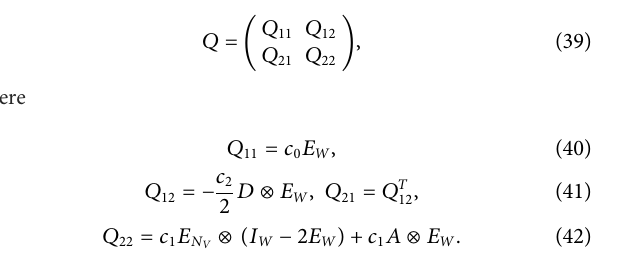
TABLE 3 Characteristics of the graph coloring dataset; the total number of instances is 900. Number of